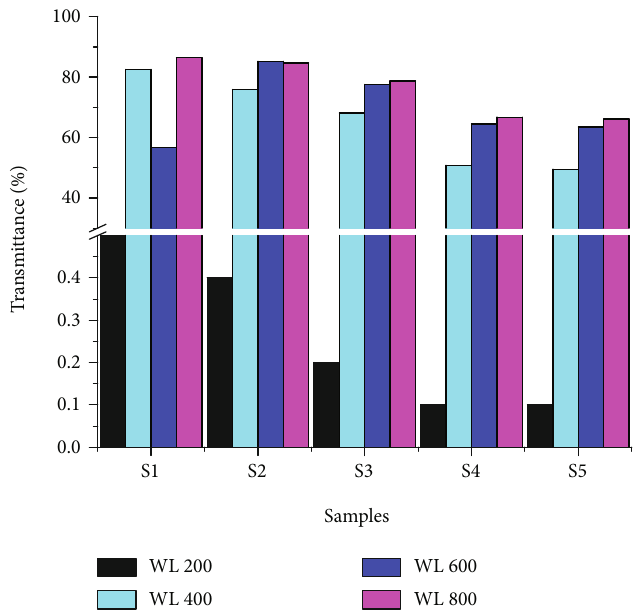
Figure 6: Light transmittance for blended fi lm (S1-100/0, S2-75/25, S3-50/50, S4-25/75, and